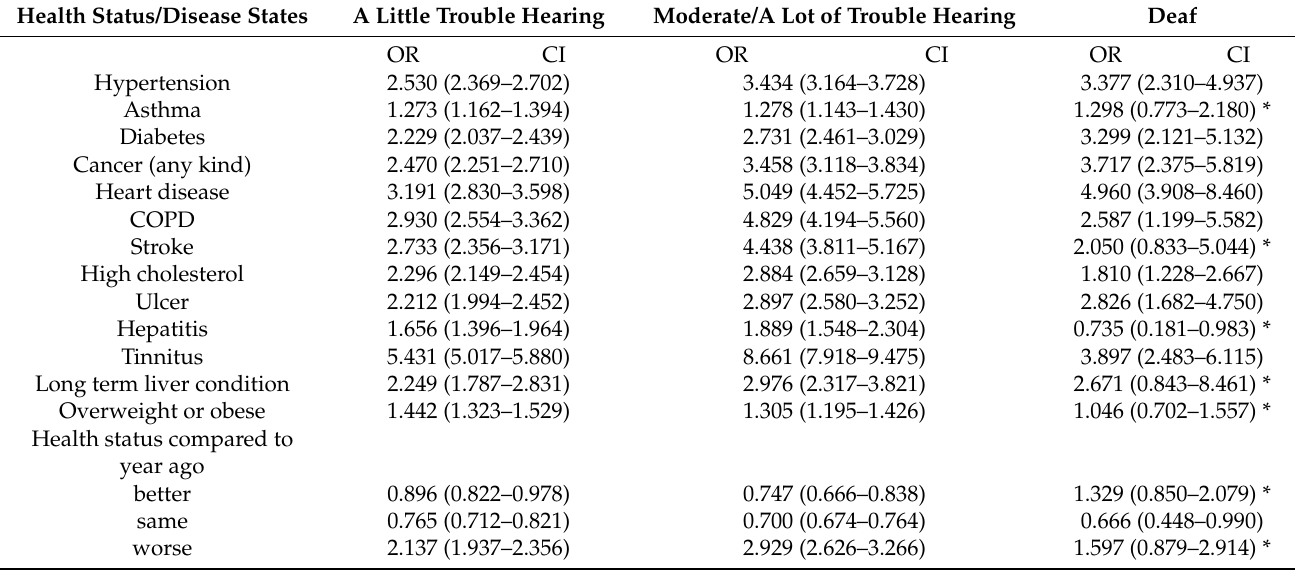
Table 3. Comparison of disease states by level of hearing loss to excellent/good hearing